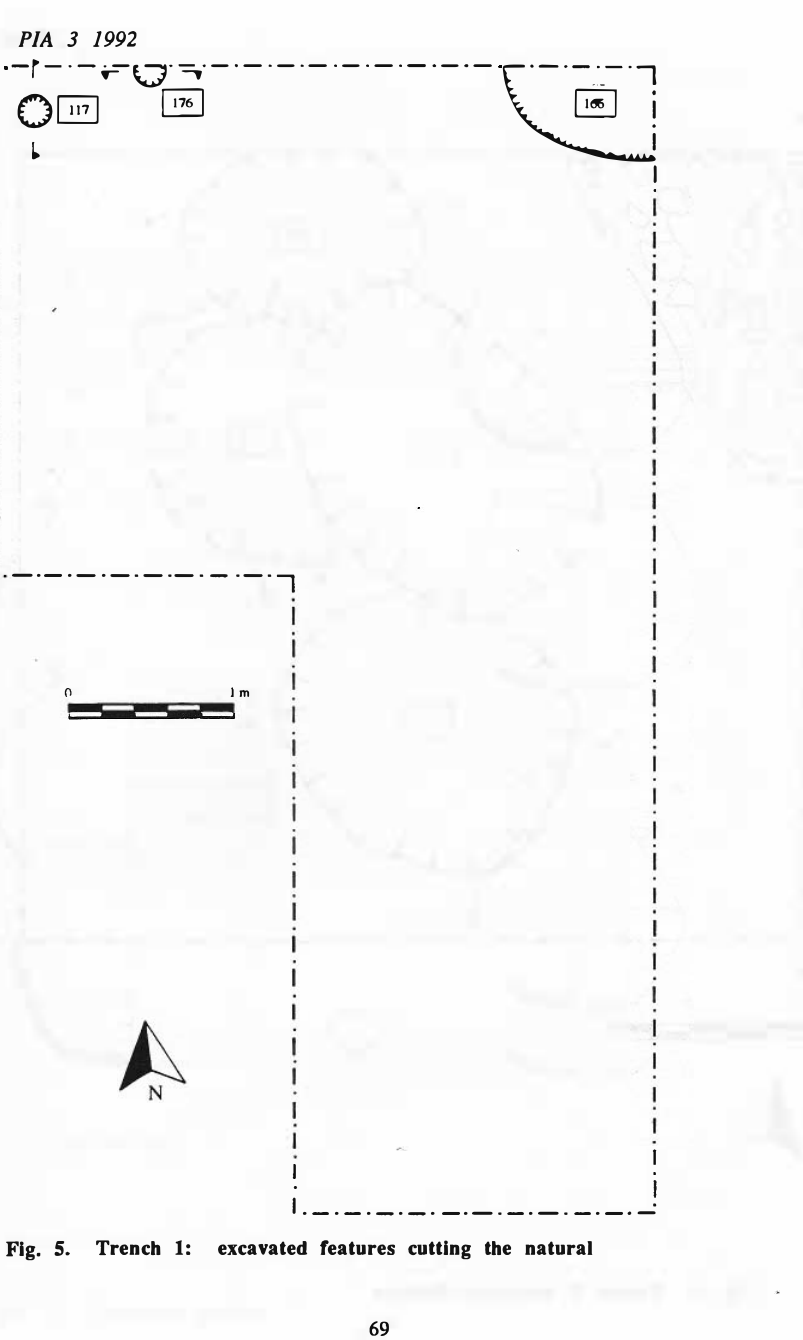
Fig. 5. Trench 1: excavated features cutting the